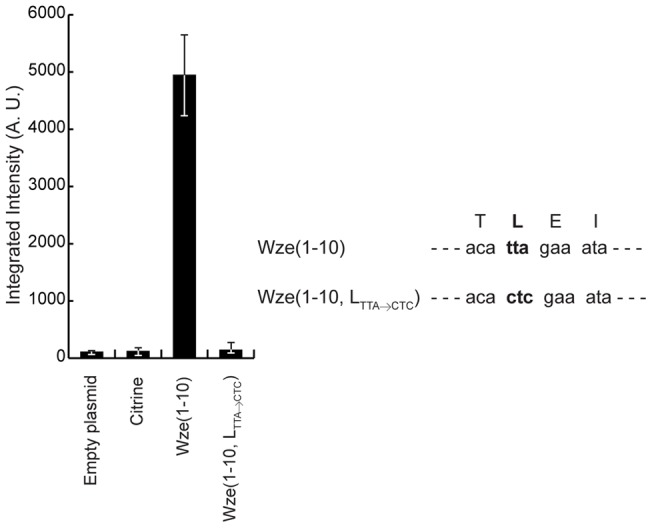
The nucleotide sequence of the i-tag determines the expression of fluorescence.(Left panel) Median fluorescence, with 25% (white error bars) and 75% (black error bars) inter-quartile range (in arbitrary units) of the fluorescence emitted by Citrine from the following strains: BCSMH031 (empty plasmid), BCSMH033 (expressing Citrine), BCSJC001 (expressing Wze(1–10)-Citrine), BCSJC006 (expressing Wze(1–10)*-Citrine in which the sequence encoding for Leucine was changed from TTA to CTC). At least 100 cells of each strain were quantified. (Right panel) Sequence encoding aminoacids 3–6 of Wze present in Wze(1–10)-Citrine and Wze(1–10)*-Citrine.